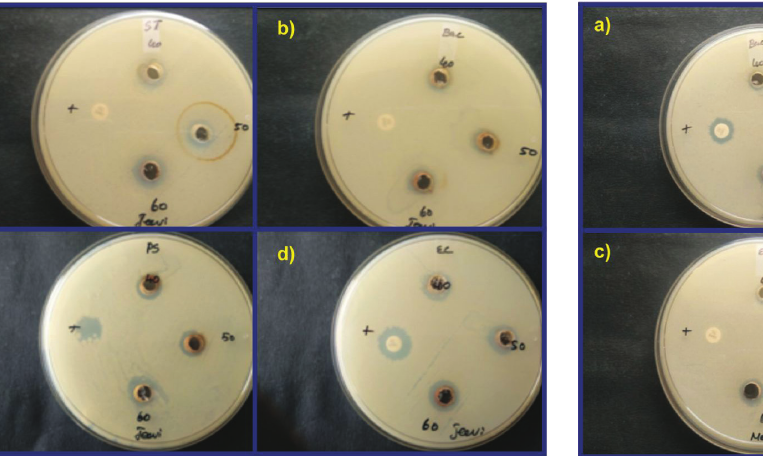
Figure 13: Antibacterial activity of Plum fruit extract mediated synthesized AgNPs: (a) Escherichia coli , (b) Staphylococcus aureus , (c) Pseudomonas aeruginosa and (d) Salmonella typhi .